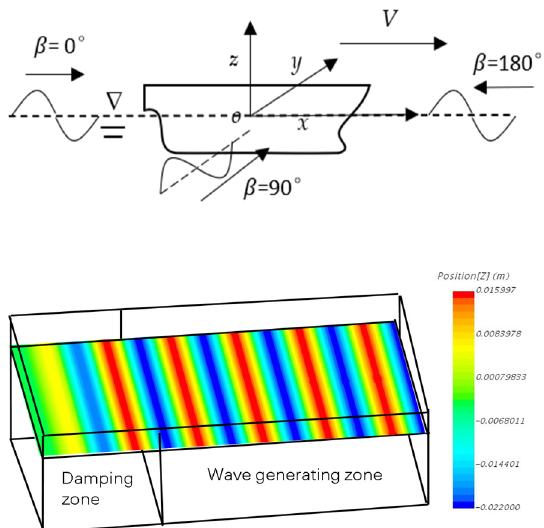
Figure 5. Coordinate system and 3D numerical wave